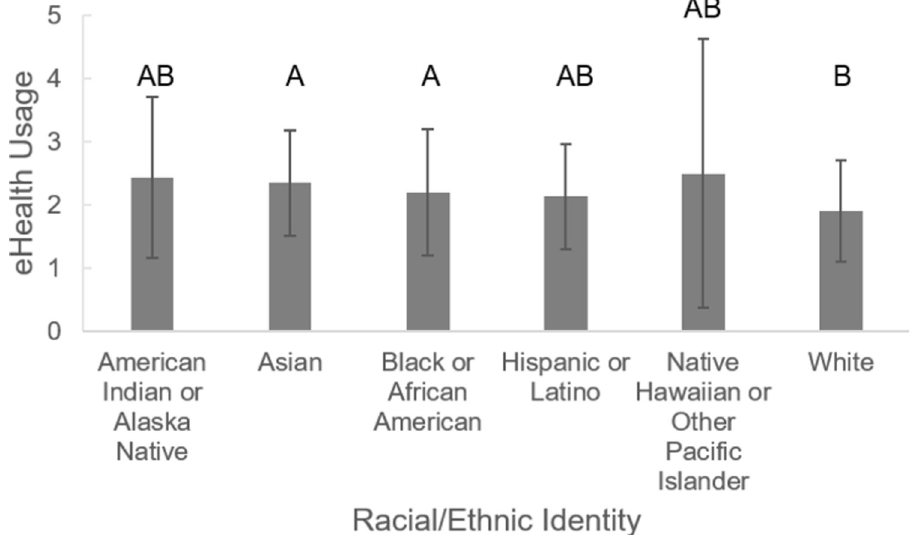
Fig 1. eHealth usage based on racial and ethnic identity. Higher values correspond to higher eHealth usage. Error bars represent standard deviations. Bars that have the same letter(s) above them do not significantly differ from each other.